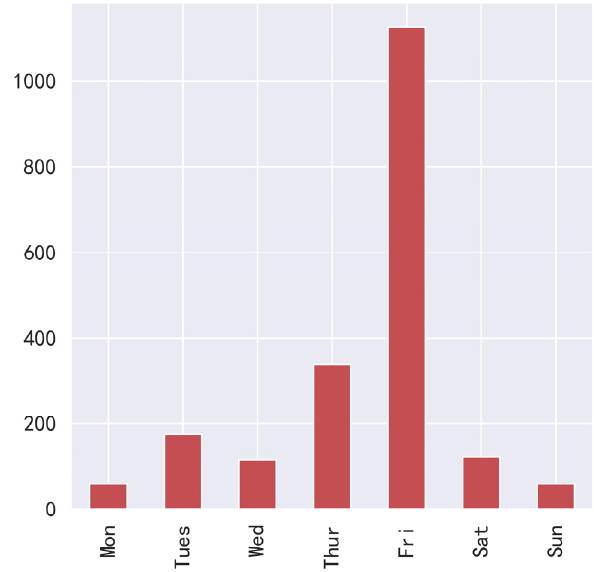
Figure 4. Which day of the week is the release date? Table 5. Movie schedule time